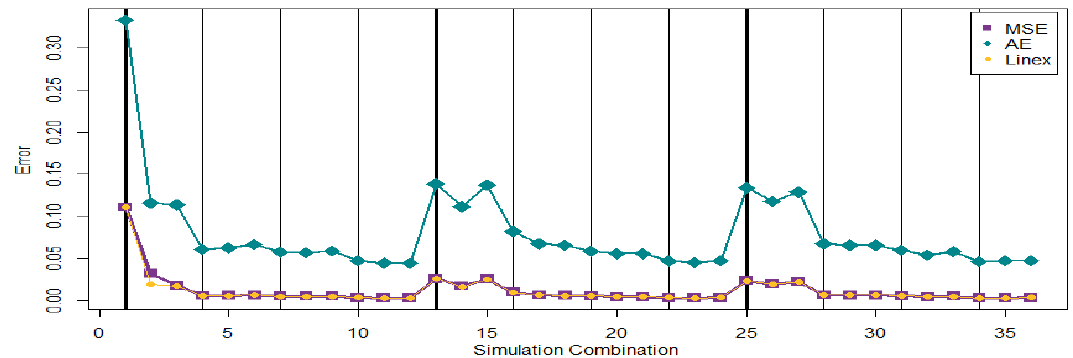
Figure 12. Overall error under β 1 (cid:54) = β 2 .